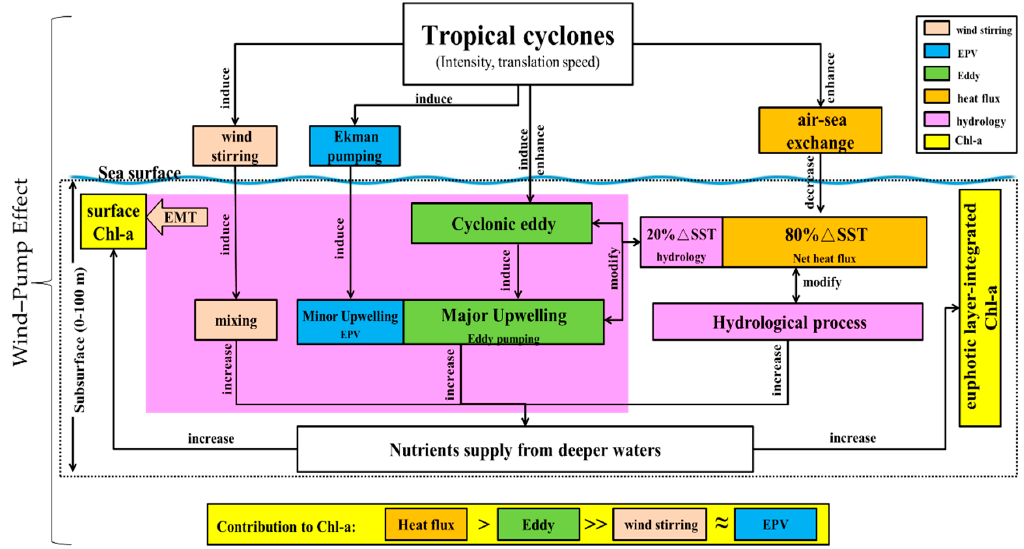
Figure 11. Graphical abstract illustrate s the Chl-a response to the typhoon “Wind Pump” impacts on upper ocean conditions and air–sea exchange. The EMT represents the Ekman mass transport, the EPV represents the Ekman pumping velocity, the black dashed line box represents the subsurface water from 0–100 m, the blue wavy line indicates the sea surface, and different colors represent different processes shown in the northeastern legend. The importance ranking of the roles in the Chl-a increasing is shown at the bottom of this figure within the yellow box.